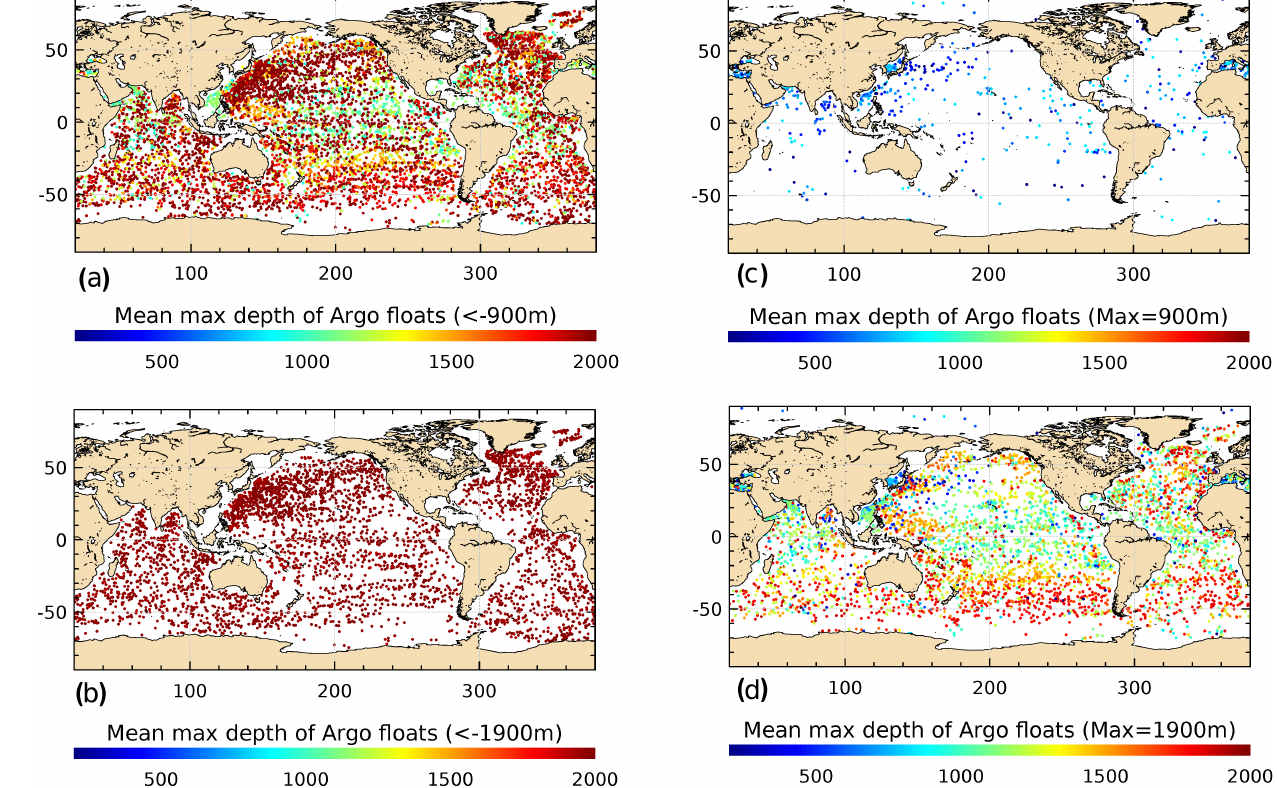
Figure 11. Maps of the mean positions of Argo floats taken into account with a given reference depth (a, b) and the associated floats which will not be used because of their mean max depth shallower than the reference (c, d) for a 900m (a, c) and a 1900m (b, d) reference depth over the period